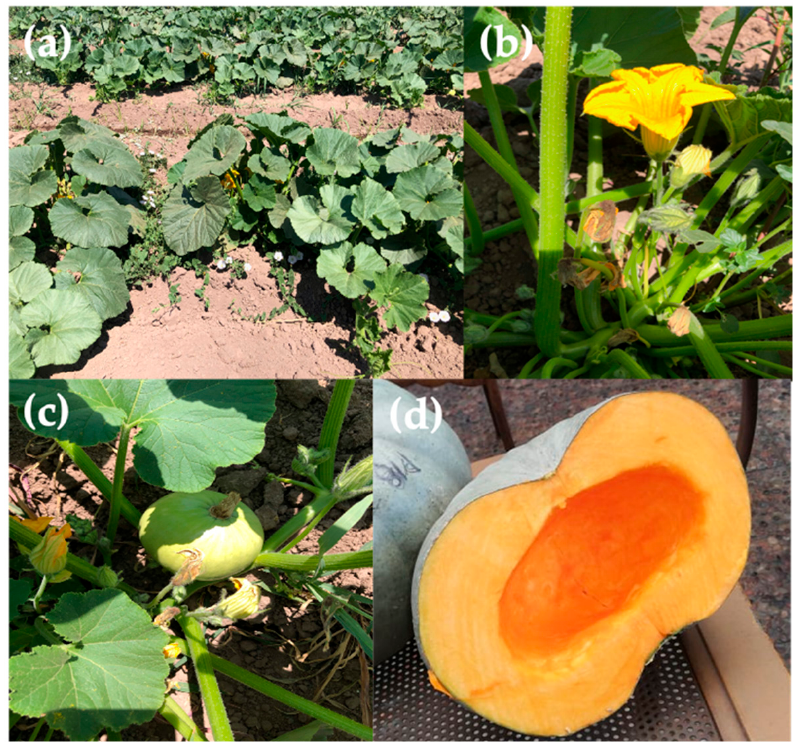
Figure 1. Habitus ( a ), flower morphology ( b ) and fruit development ( c , d ) of Cucurbita maxima var. Paine at the study site.